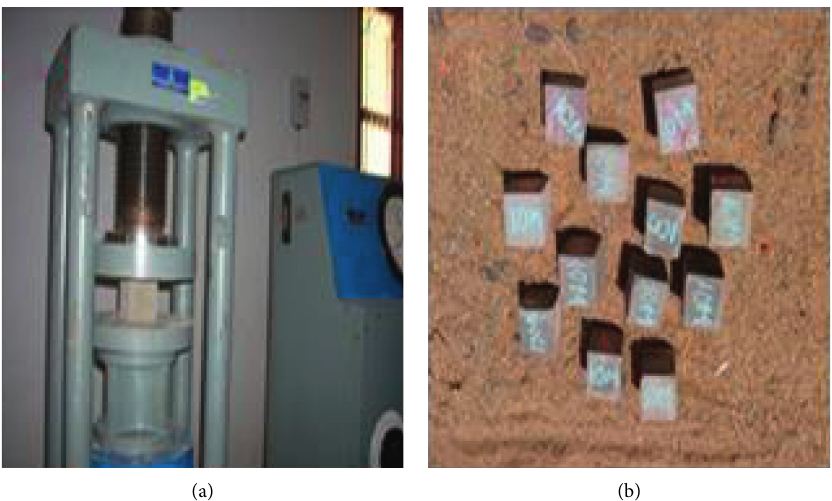
Figure 6: Compressive strength test. (a) Compression test on a mortar cube. (b) Geopolymer mortar